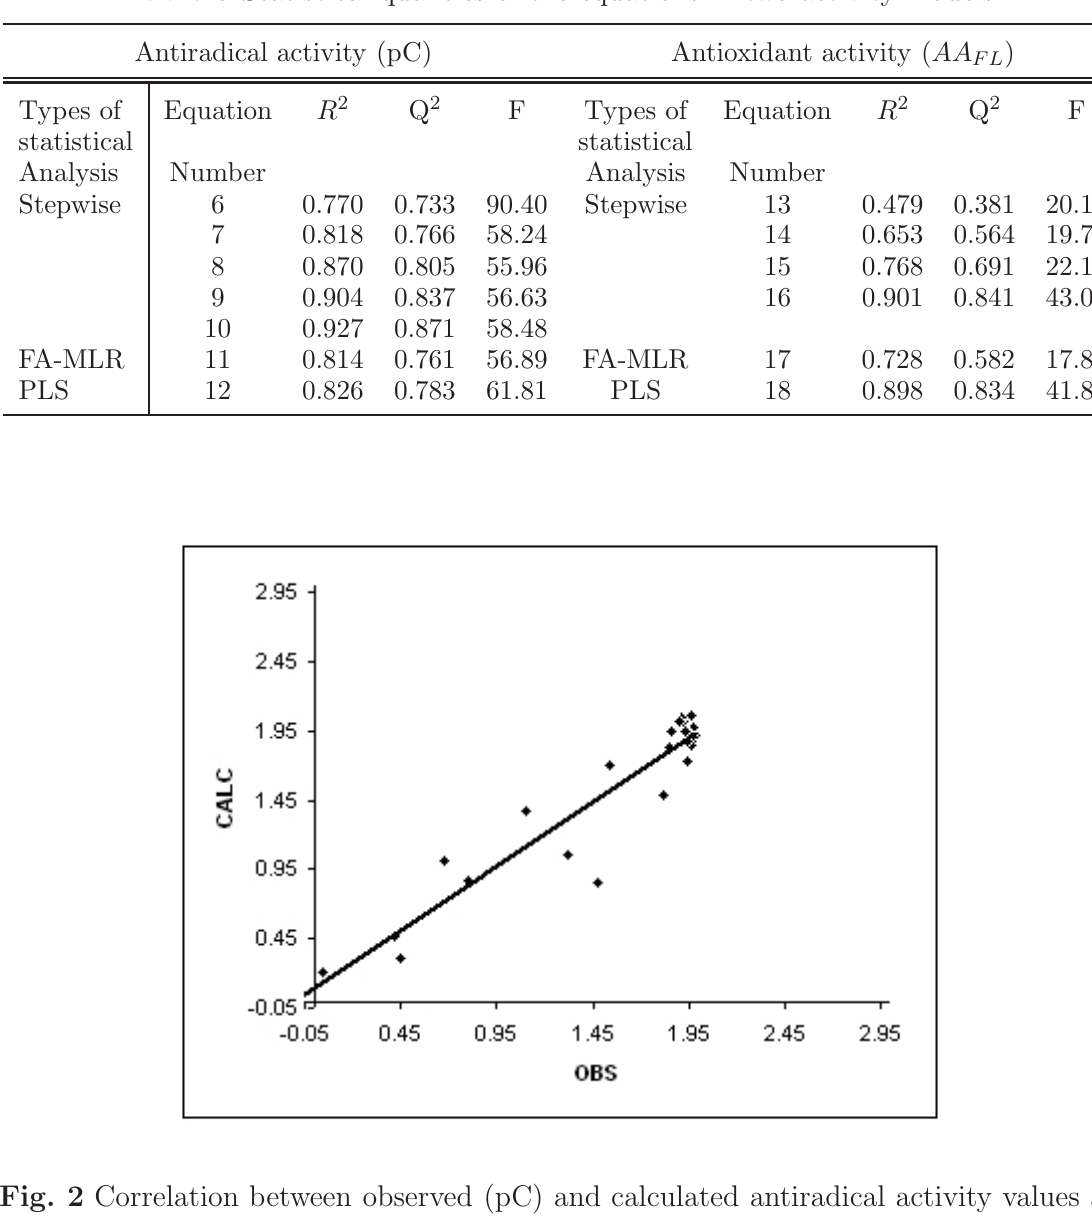
Table 5 Statistical qualities of the equations in two activity models.